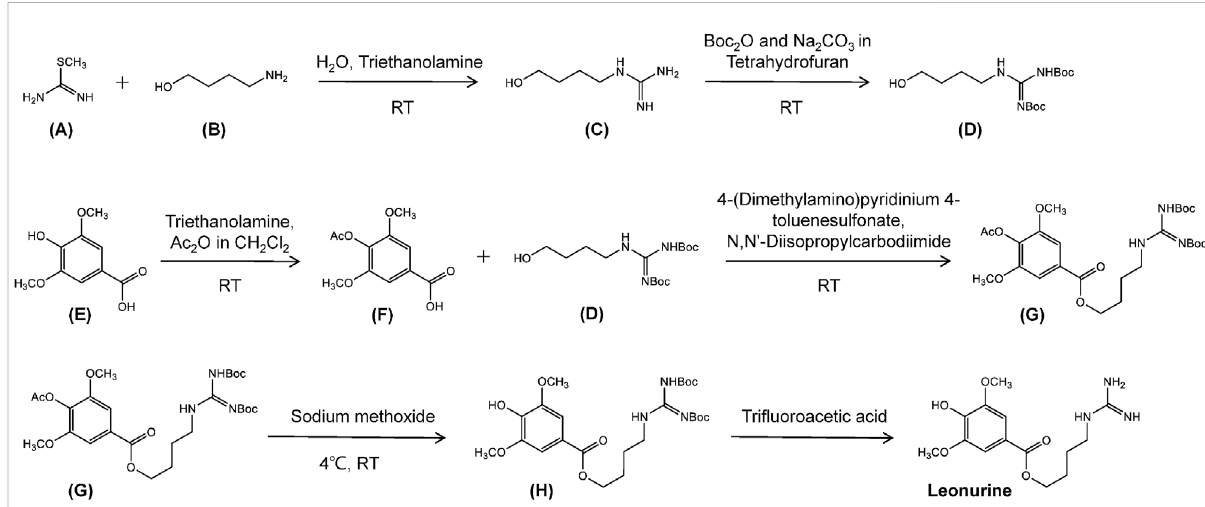
FIGURE 7 The chemical synthesis route of leonurine. RT, room temperature. Ac 2 O, acetic anhydride. Boc, tert-butoxycarbony group. (A) S-methyl- isothiourea. (B) 4-Amino-1-butanol. (C) N-(4-Hydroxybutyl). (D) Boc-protected N-(4-Hydroxybutyl)guanidine. (E) Caryophyllic acide. (F) 4- Acetoxy-3,5-dimethoxybenzoic acid. (G) Boc-protected 4-[(Aminoiminomethyl)amino]butyl 4-(acetyloxy)-3,5-dimethoxybenzoate. (H) Boc- protected